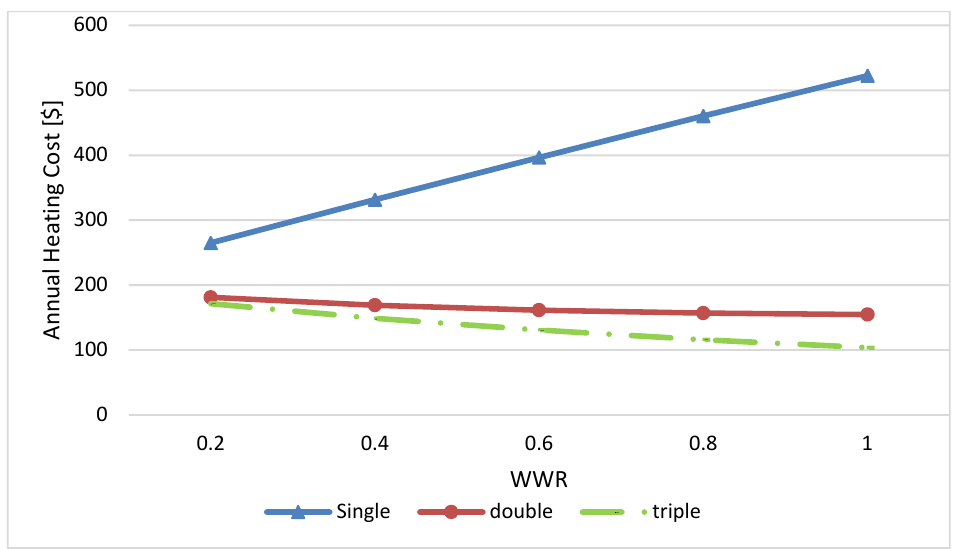
Figure 7. The influence of the window-to-wall ratio on the annual heating cost in Hakkari (3 cm insulation, NW oriented) .